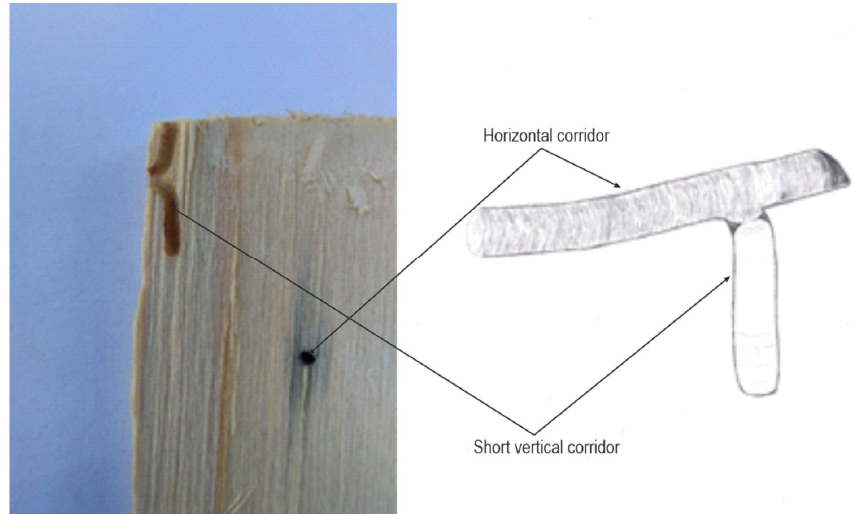
Figure 4. Short vertical corridors directed upwards and downwards at the end of the horizontal corridor.